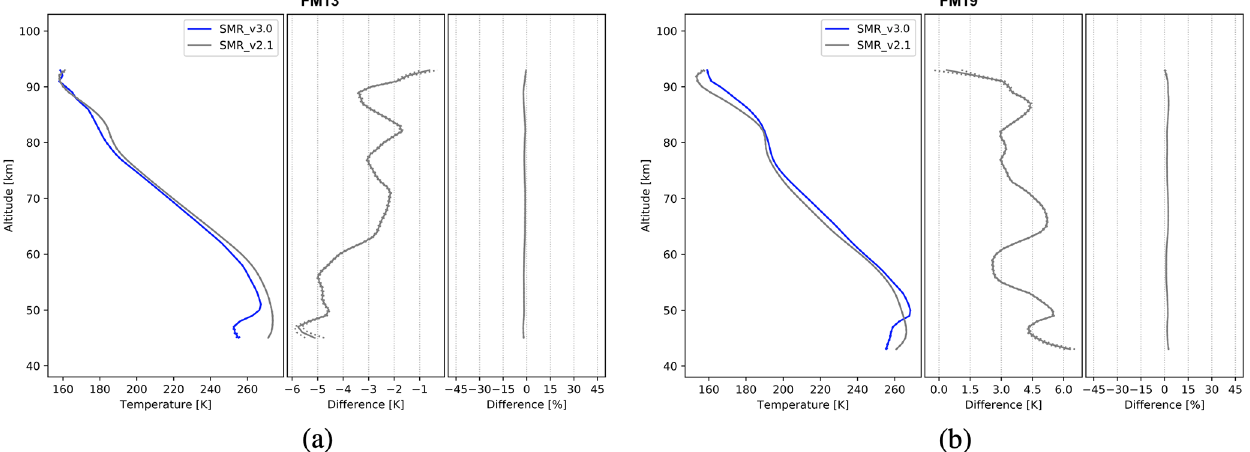
Figure A7. Comparison of SMR v3.0 and v2.1 temperatures from FM13 (a) and FM19 (b) . The data plotted are global averages over the time period between February 2001 and April 2019. Figure characteristics are the same as in Fig. 6.